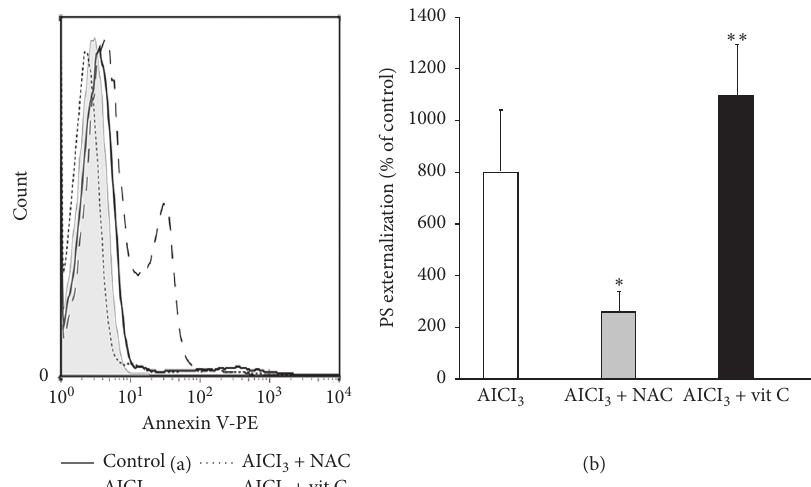
Figure 4: The effect of vit C and NAC on Al-induced PS externalization using Annexin V-PE flowcytometric methods. (a) Histogram of PS externalization of erythrocytes following exposure for 24hours to Ringer solution (control; grey area), AlCl 3 (100 μ M; black line), AlCl 3 (100 μ M) and vit C (0.6mM; dashed line), AlCl 3 (100 μ M), and NAC (1.0mM; dotted line). (b) Arithmetic means ± SD of the percentage of erythrocyte with enhanced PS externalization following treatment with AlCl 3 in the presence and absences of vit C (0.6mM) and NAC (1mM) in Ringer solution for 24hours. ∗ and ∗∗ P < 0.05 significant difference compared to the AlCl 3 -treated